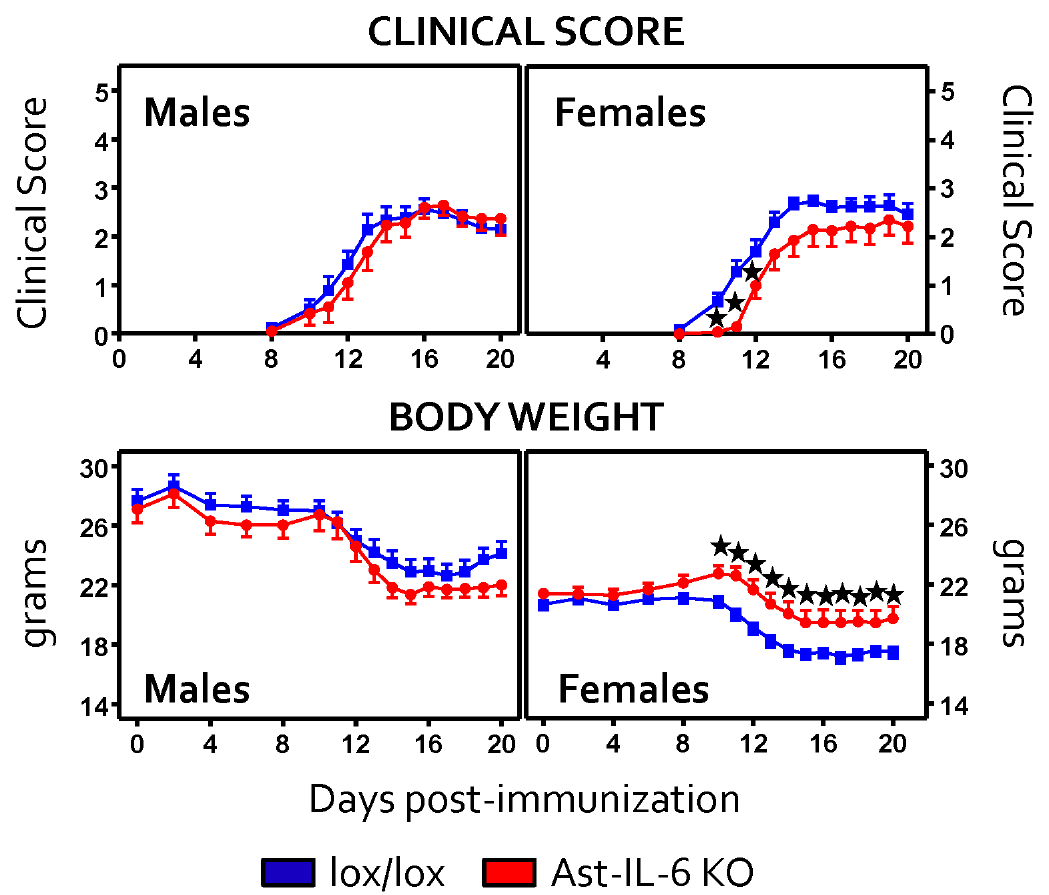
Figure 1. Clinical course of EAE, in both floxed ( n = 18 males, 28 females) and Ast-IL-6 KO ( n = 11 males, 23 females) mice up to 20 dpi. Results are the mean ± SEM of data pooled from Experiments 1–3 (Days 0–20 dpi; Table 1). ★ p at least <0.05 versus floxed mice at specific days following a post-hoc analysis.